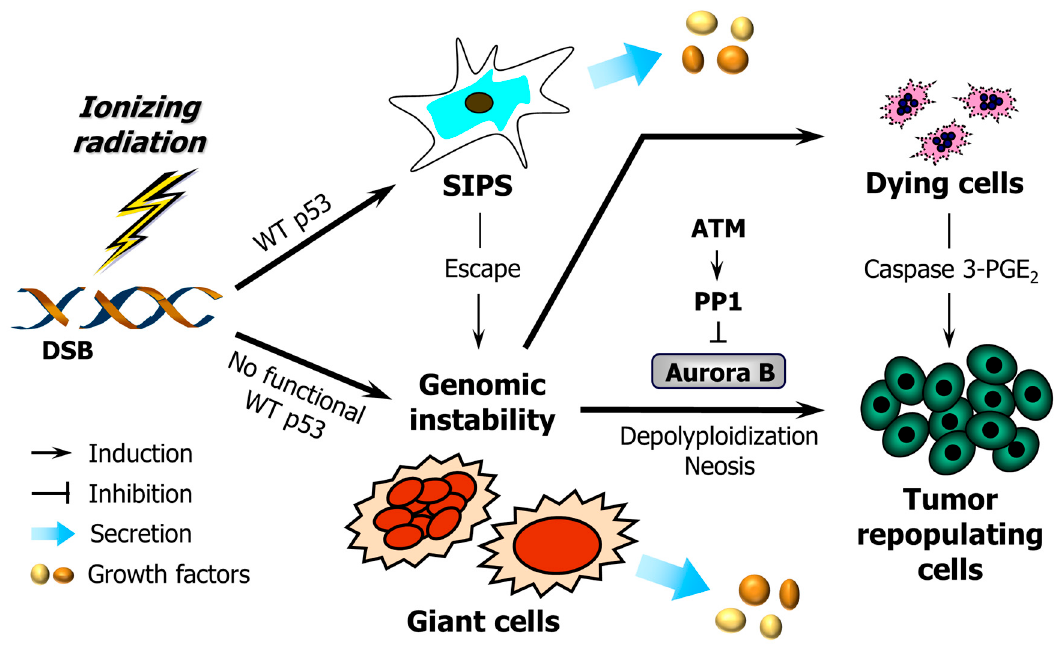
Figure 1. The DNA damage response of human cells with differing p53 status discussed in this article. Ionizing radiation triggers growth arrest through stress-induced premature senescence (SIPS) in p53 wild-type (WT) cells, and the development of giant cells (containing multiple nuclei or a single enlarged nucleus) within cultures of cancer cells lacking wild-type p53 function. In addition, a proportion of p53 WT cells “escapes” from SIPS and gives rise to giant cells. While some giant cells may die through apoptosis, others may undergo complex genome-reduction processes (e.g., depolyploidization and neosis), ultimately giving rise to rapidly-proliferating progeny. The mitotic kinase Aurora B plays an important role in regulating the survival of giant cells. ATM may prevent the propagation of giant cells and their descendants by activating protein phosphatase 1 (PP1) and inhibiting Aurora B kinase activity [37,47]. Caspase 3 either functions as the executioner caspase in the apoptotic pathway or, paradoxically, promotes cell survival by mediating prostaglandin E 2 (PGE 2 ) secretion. DSB, double-strand break; ATM, ataxia telangiectasia mutated.